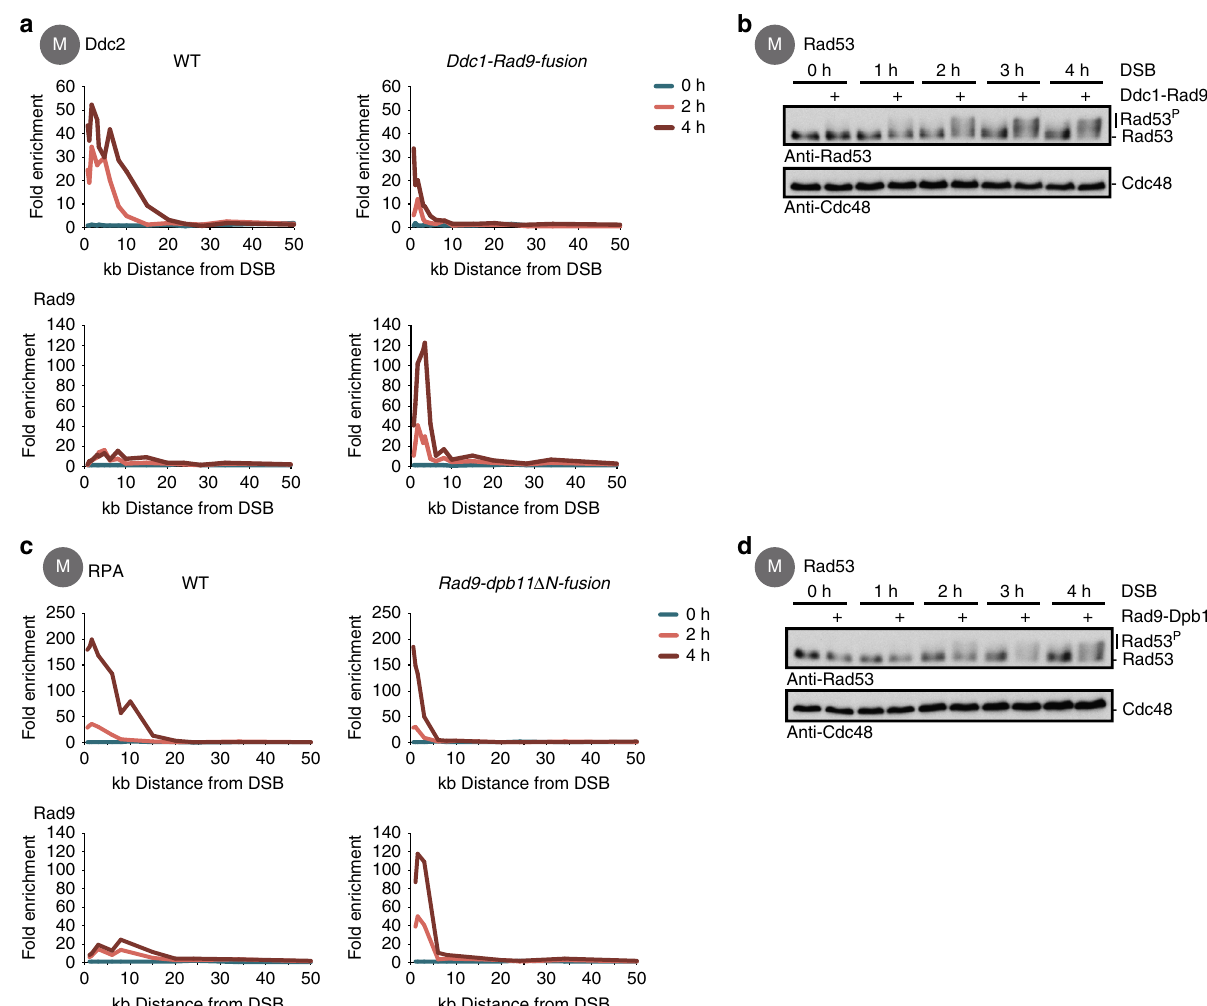
Fig. 4 Hyper-activation of the 9-1-1 axis enhances Rad53 activation even at low levels of Mec1 recruitment. a A covalent Ddc1-Rad9 interaction results in enhanced Rad9 recruitment and blocks Mec1 – Ddc2 kinase recruitment to a double-strand break (DSB). Wild-type (WT) cells and DDC1-RAD9-fusion cells (same construct as used in Fig. 1f – g) were arrested in M phase and analysed at indicated times. Depicted are chromatin immunoprecipitation (ChIP)- quantitative PCR (qPCR) measurements of Mec1 – Ddc2 recruitment (upper panels, ChIP directed against Ddc2 – 3FLAG using an anti-FLAG antibody) and Rad9 recruitment to a DSB (lower panels, ChIP directed against Rad9 or the fusion which both carry a 3FLAG tag for detection). b Rad53 activation in response to a DSB is strongly enhanced in cells expressing a DDC1-RAD9-fusion construct. Western blot analysis of Rad53 activation at indicated times after DSB induction, strains as in a . Cdc48 served as loading control (lower panel). c A covalent Rad9-Dpb11 fusion protein enhances Rad9 recruitment to the DSB and blocks DNA end resection. WT cells and cells expressing RAD9-dpb11 Δ N (lacking BRCT 1 + 2 of Dpb11 which normally bind to Rad9) were arrested in M phase and analysed at indicated time points. ChIP-qPCR measurements of DNA resection (replication protein A (RPA), upper panels) and Rad9 recruitment to a DSB (lower panels). To measure Rad9 recruitment, Rad9-dpb11 Δ N-fusion and Rad9, respectively, were tagged C-terminally with a